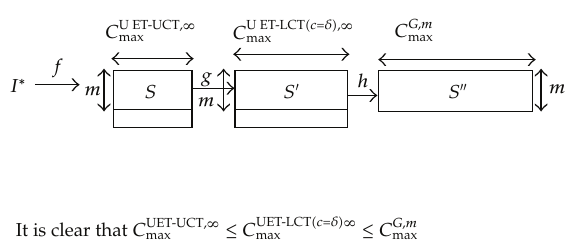
Figure 9: Description of chain of polynomial-time